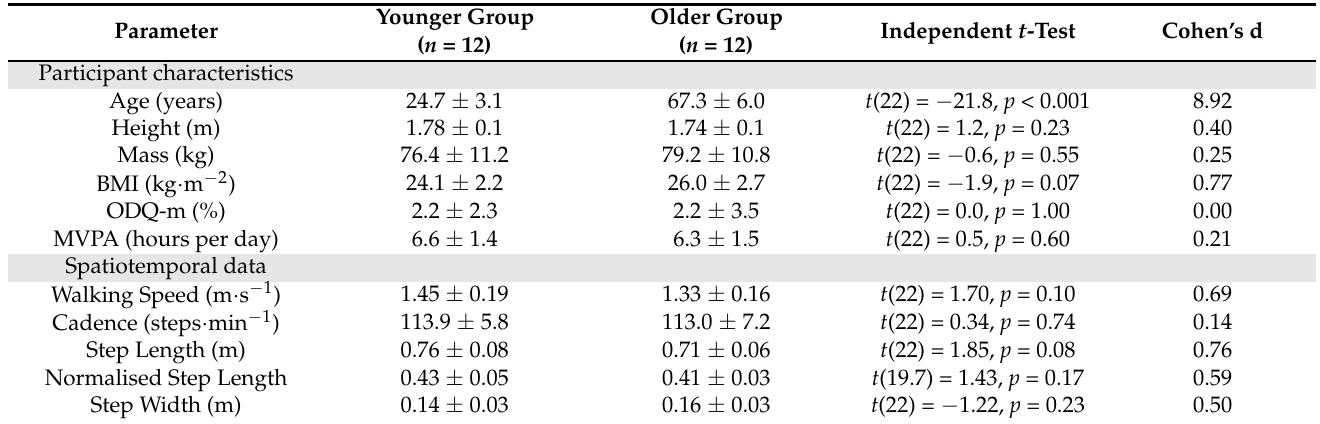
Table 1. Participant characteristics and spatiotemporal parameters during normal gait (mean ± SD) for the younger and older